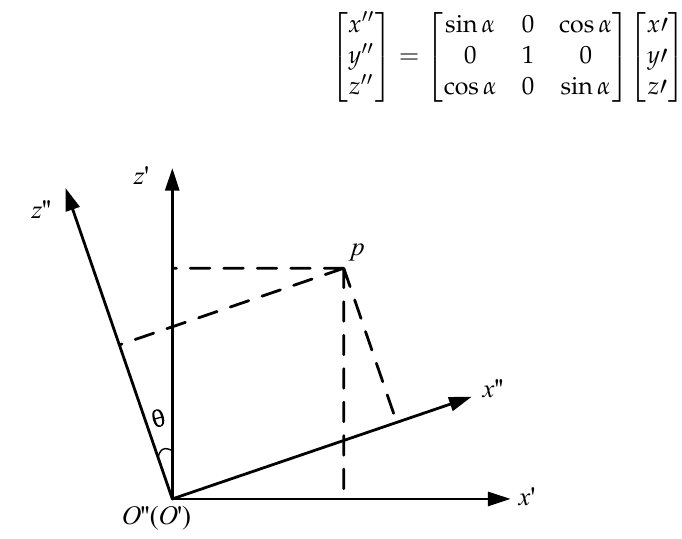
Figure 14. Conversion of coordinate systems.